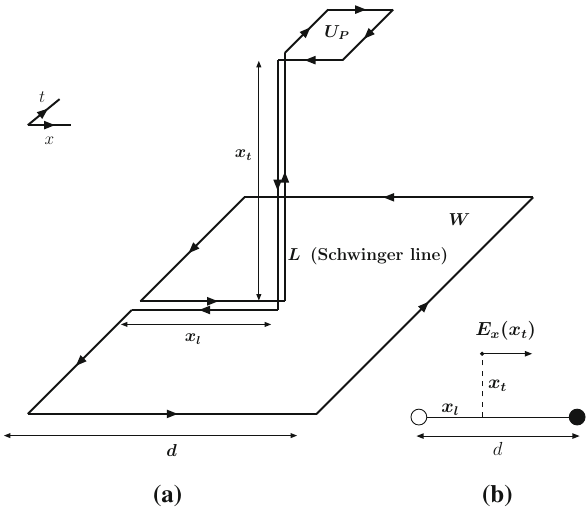
Fig. 1 a The connected correlator given in Eq. (1) between the plaque- tte U P and the Wilson loop (subtraction in ρ conn not explicitly drawn). W ,μν b The longitudinal chromoelectric field E x ( x t ) relative to the position of the static sources (represented by the white and black circles), for a given value of the transverse distance x t